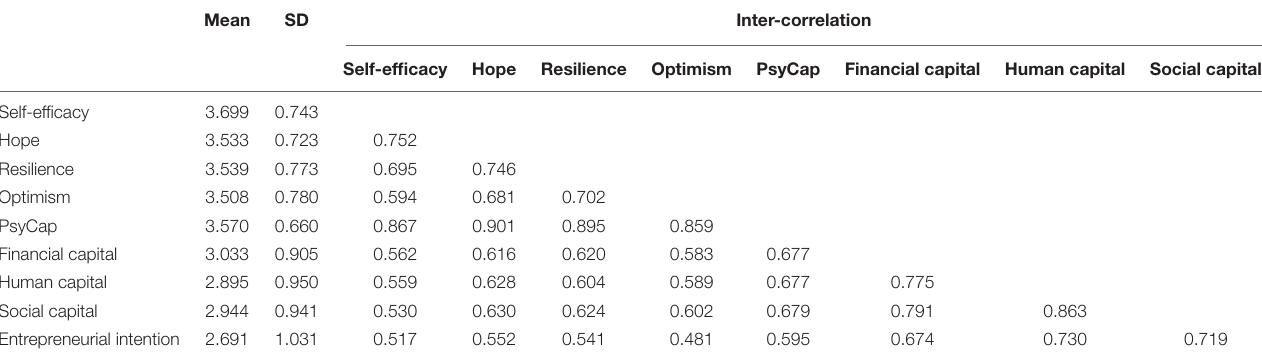
TABLE 2 | Descriptive statistics and variable